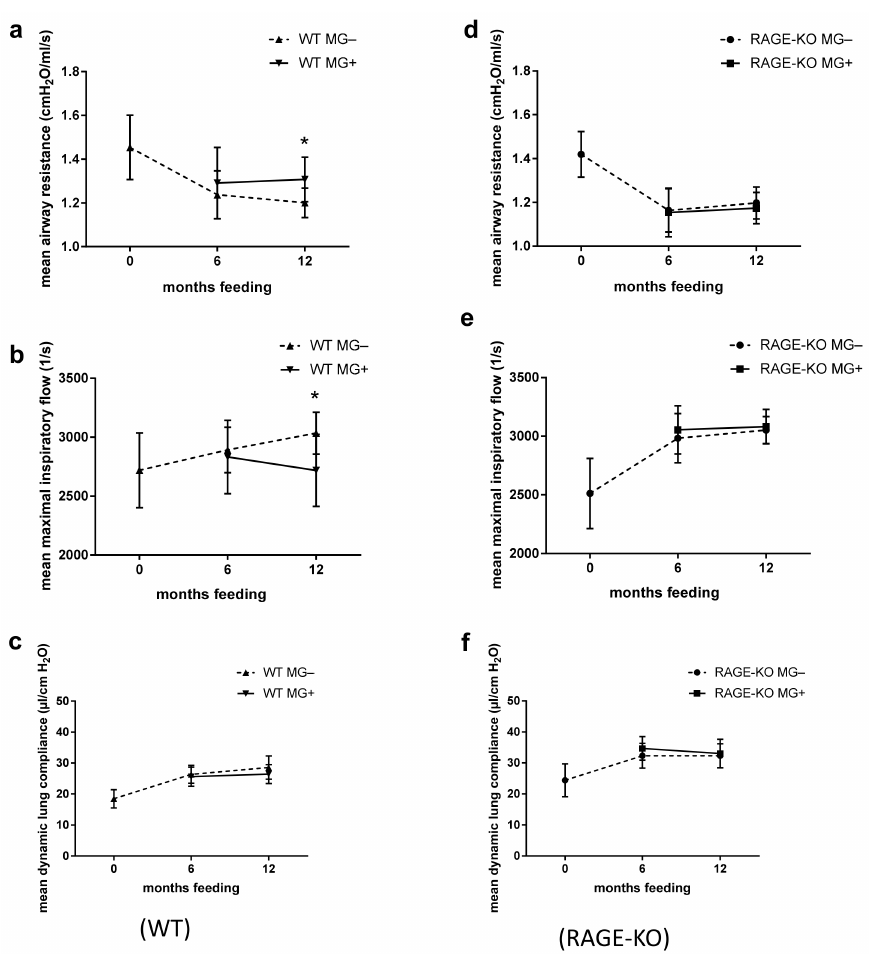
Figure 1. Effect of long-term oral supplementation with Methylglyoxal (MG) on lung biomechanics. Airway resistance, airway maximal inspiratory flow, and dynamic compliance of isolated lungs from ( a – c ) wild type (WT) and ( d – f ) RAGE knockout (RAGE-KO) mice after 6 and 12 months feeding with MG. Data are shown as mean SD ( n = 10–15 each group and time point). Means were statistically compared by two-way ANOVA followed by Sidak’s multiple comparison test; * p <